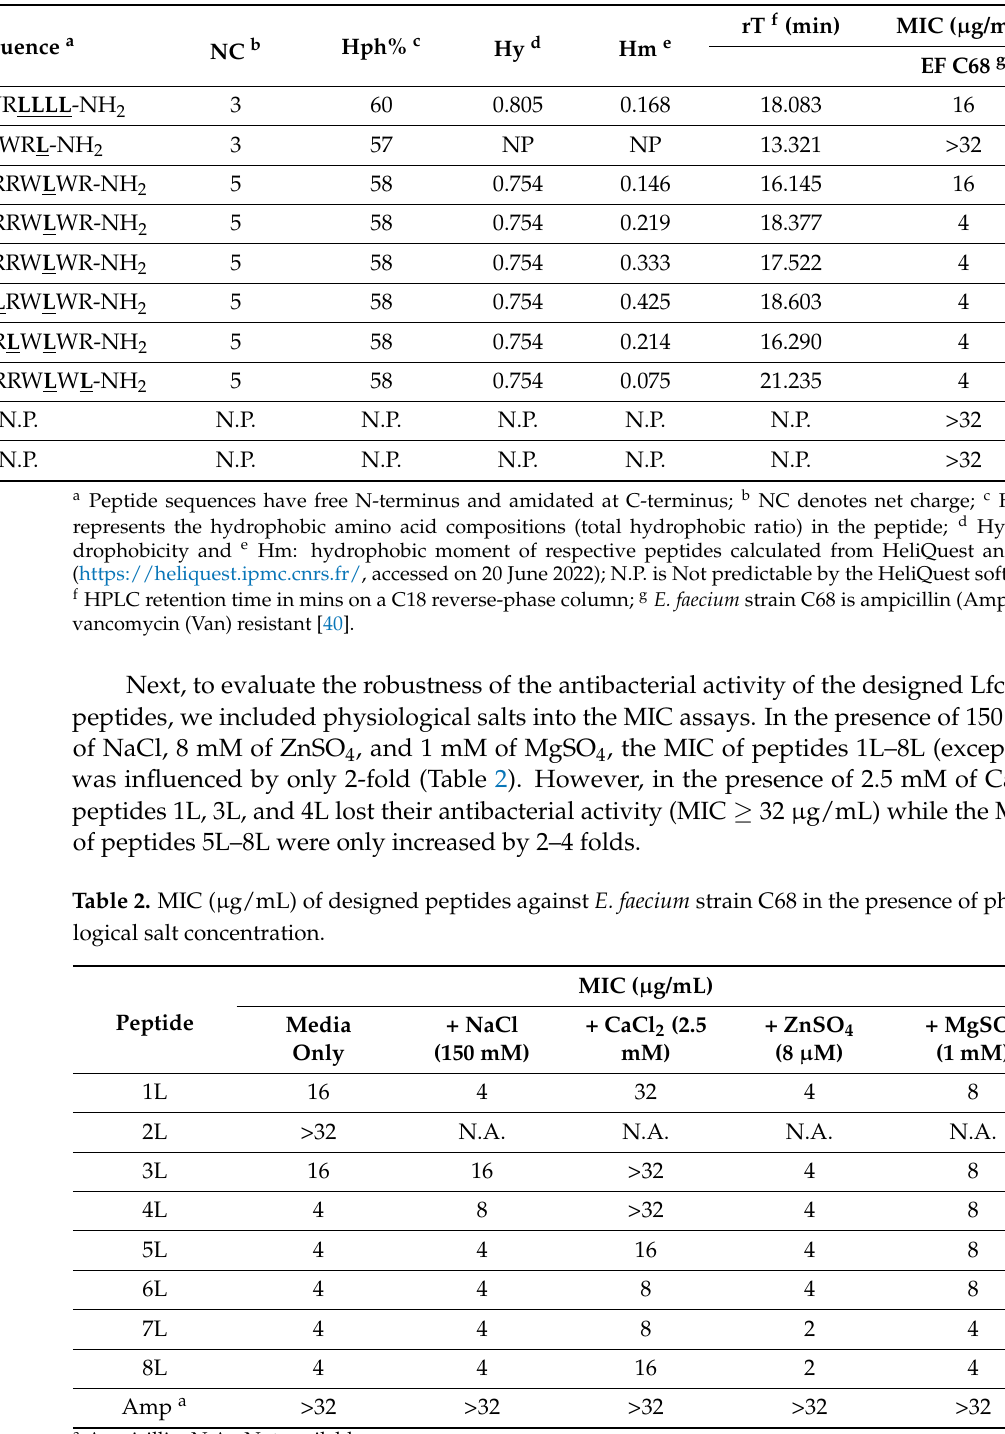
Table 1. Physical parameters and the minimal inhibitory concentration ( µ g/mL) of designed peptides against E. faecium .